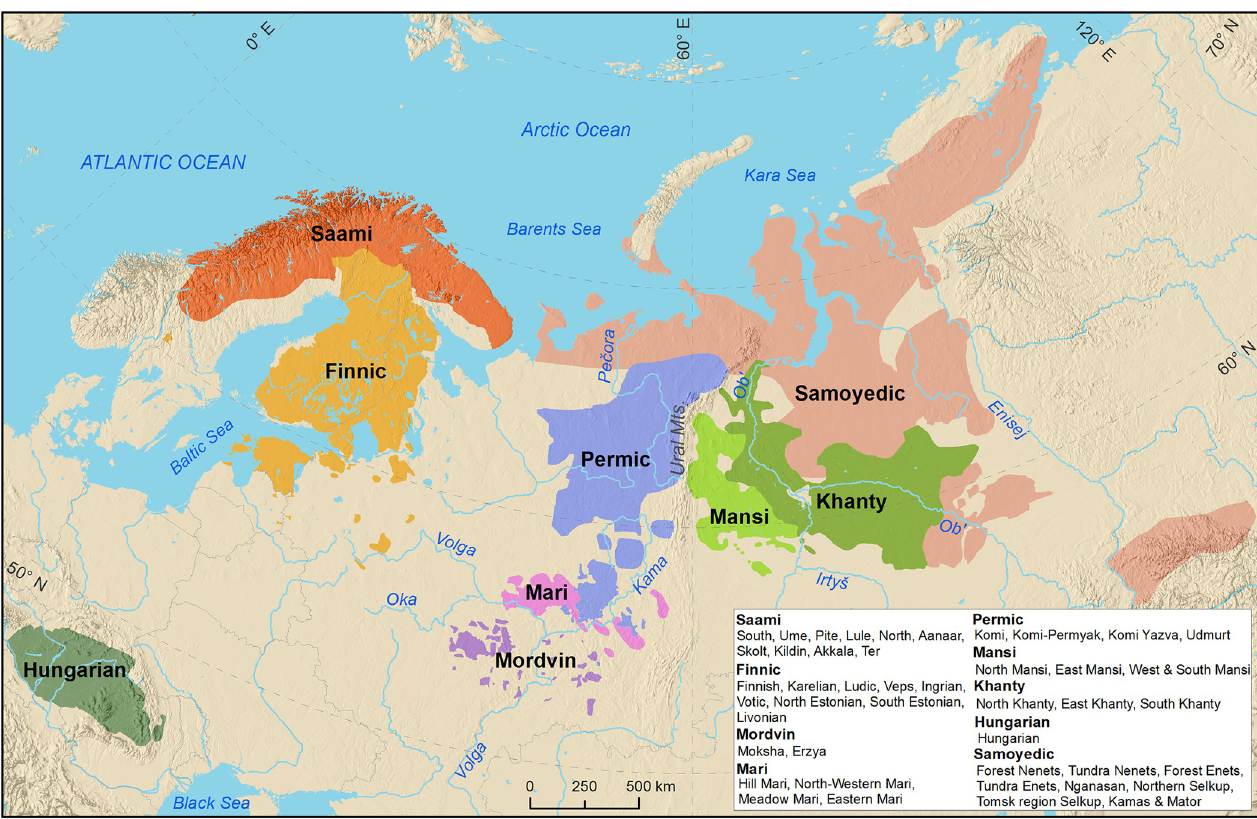
Fig 3. Geographical distribution of the Uralic languages at the beginning of the 20th century. The uncontroversial branches of the family are presented without overlapping areas. A list of original sources is available in S2 Appendix. Basemap datasets from Natural Earth [43], Digital Chart of the World [44] and ESRI